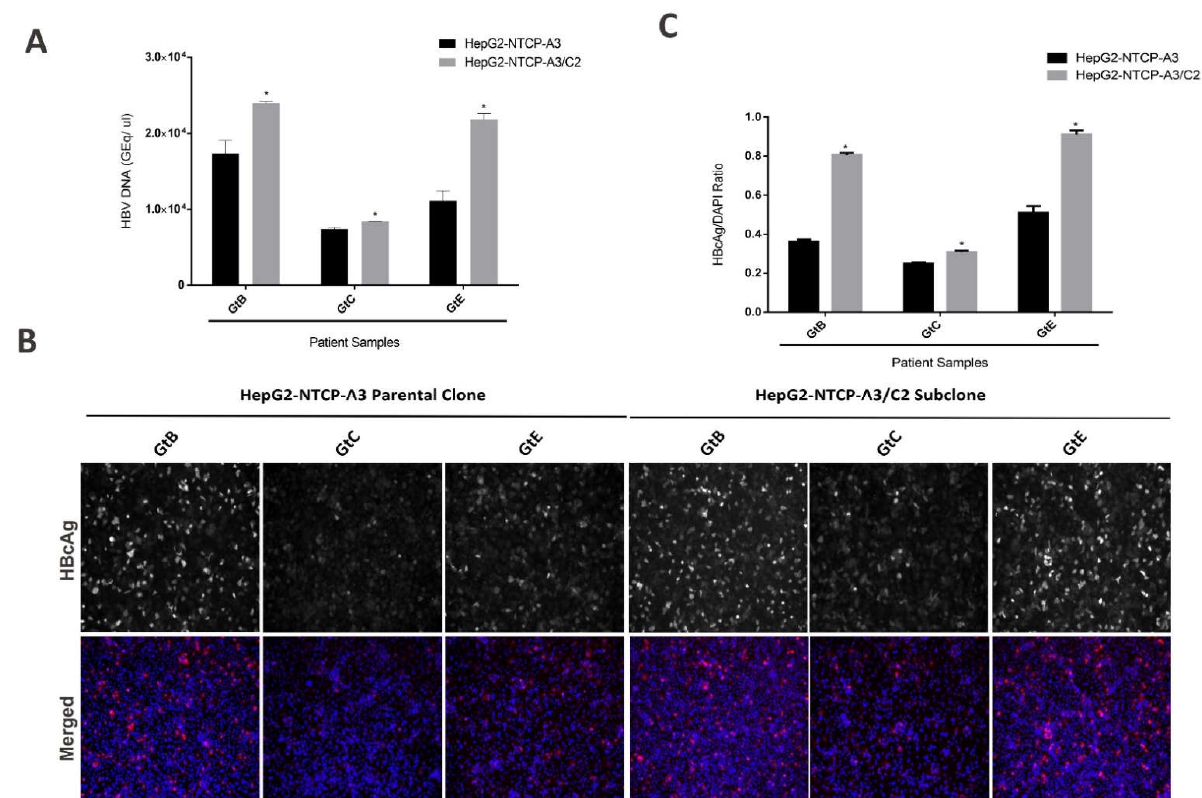
Figure 3. Susceptibility of C2 subclone to HBV Clinical isolates. ( A) HepG2-NTCP-A3 parental clone and C2 subclone were infected with three sequence confirmed genotype B, C and E patient samples. Supernatants were collected at day 7 post-infection and the amount of HBV DNA was quantified by real-time PCR; ( B ). HBV infected cells were fixed and immunostained with an antibody to HBcAg and counterstained with DAPI. The cells were visualized by fluorescence microscopy; ( C ). HBcAg fluorescence over DAPI shown as a ratio. Data are presented as mean ± SD ( t -test; p < 0.05, * level of significance).